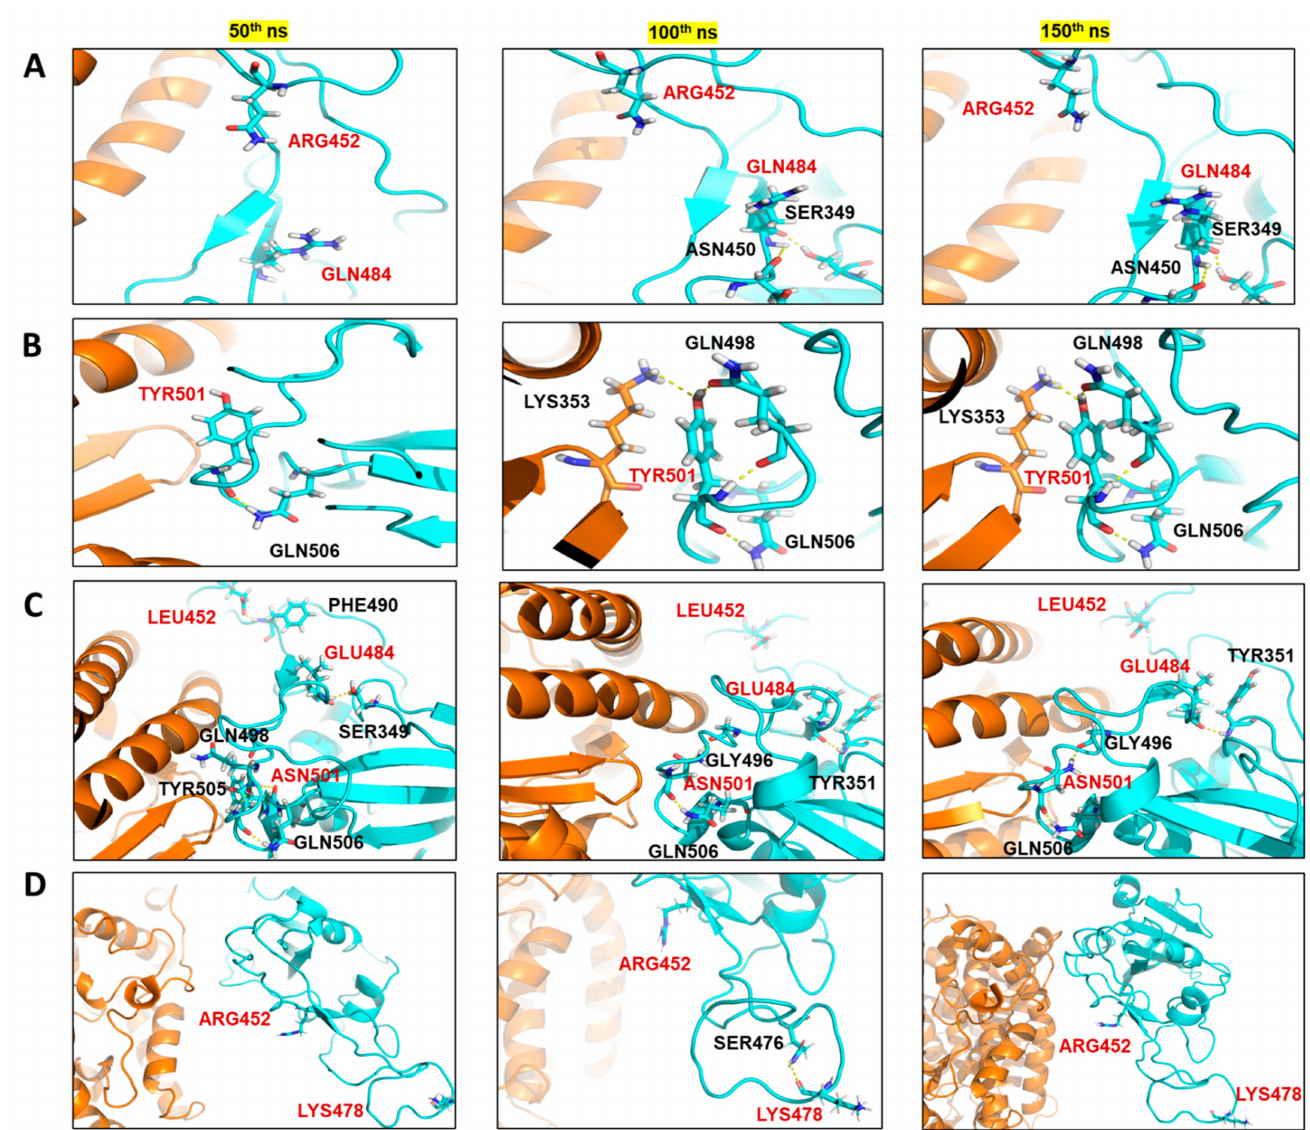
Figure 3. Comparing the interaction of the mutated residues and wild-type residues in the three structures extracted at 50 ns span from the simulated trajectories: spike protein (turquois color), and hACE2 (orange color). ( A ) Kappa spike variant and its interactions; Gln484 of the spike protein making intra-chain hydrogen bonding with Ser349 and Asn450 in the 100th and 150th ns frame. ( B ) Alpha spike variant interactions. The hydrogen bond interaction of Tyr501 of mutant spike protein with Lys353 of hACE2 in the 100th and 150th ns frame. ( C ) The interaction of wild type residues at 50th, 100th and 150th ns of the simulation shows that Glu484 of spike protein had only one hydrogen bond interaction with Ser349 or Tyr351 of spike itself. Similarly, Asn501 of spike was making hydrogen bond interactions with its residues only. ( D ) In the Delta spike variant, at 100th ns frame, an addition of a hydrogen bond of Lys478 with Ser476 was